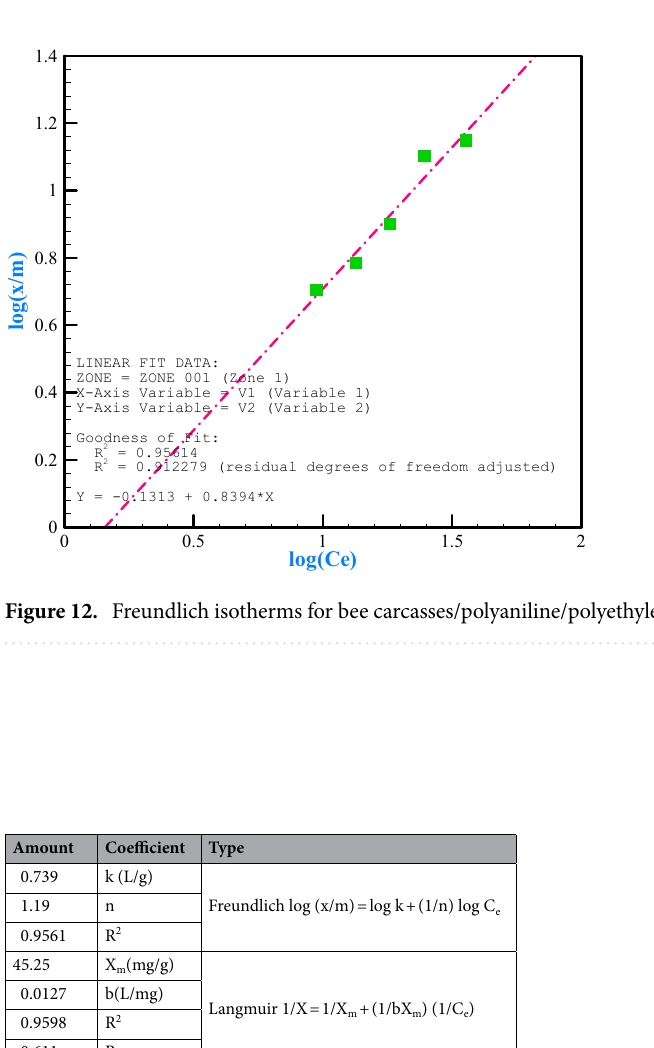
Figure 11. Langmuir isotherms for bee carcasses/polyaniline/polyethylene glycol composite.